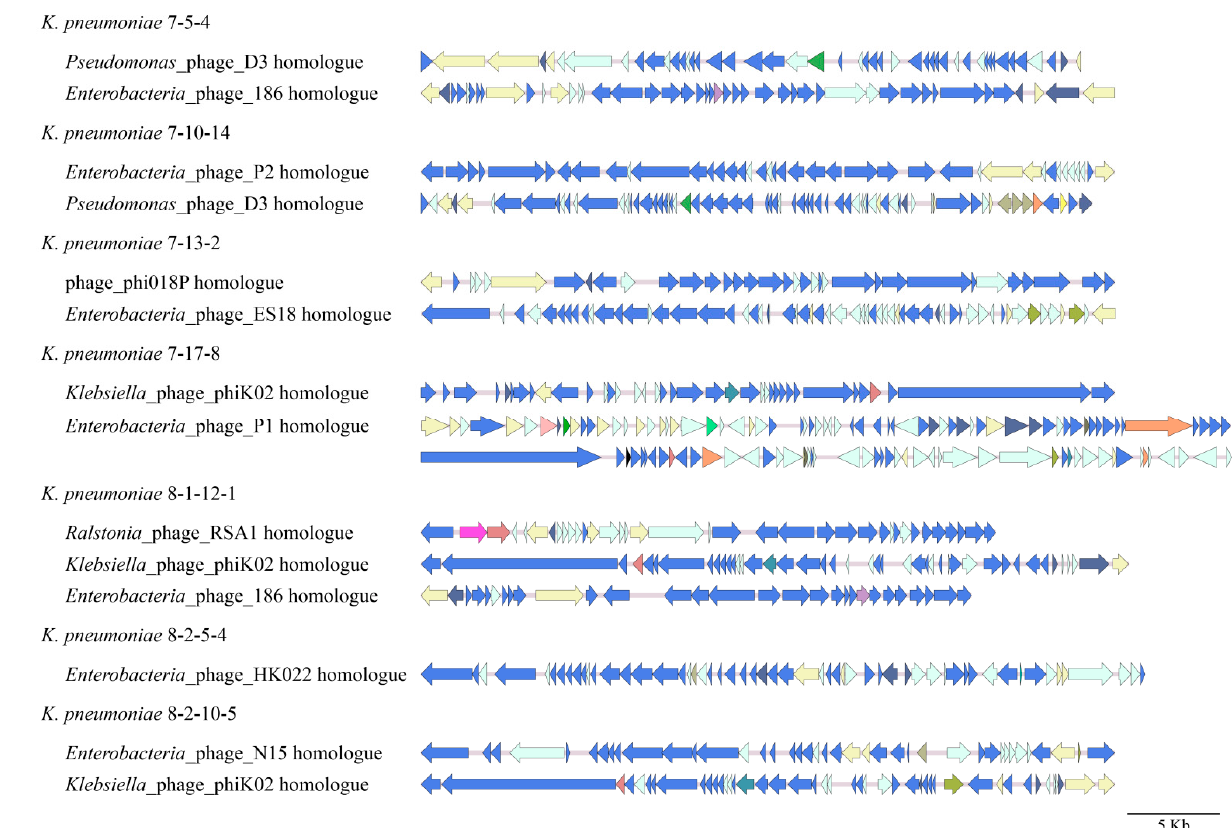
Figure 3. Gene organizations of the GIs identi fi ed in the K. pneumoniae genomes ( A , B ). Di ff erent colors referred to COG classi fi cation to mark gene functions, and genes not annotated to COG da- tabase were displayed in grey.